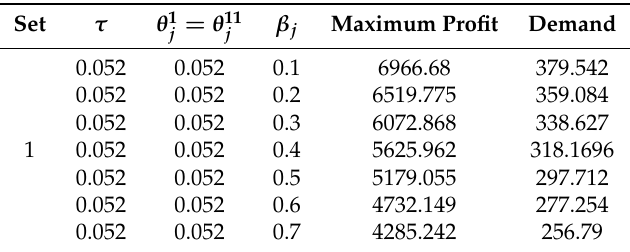
Table 13. Sensitivity analysis (w.r.t β j